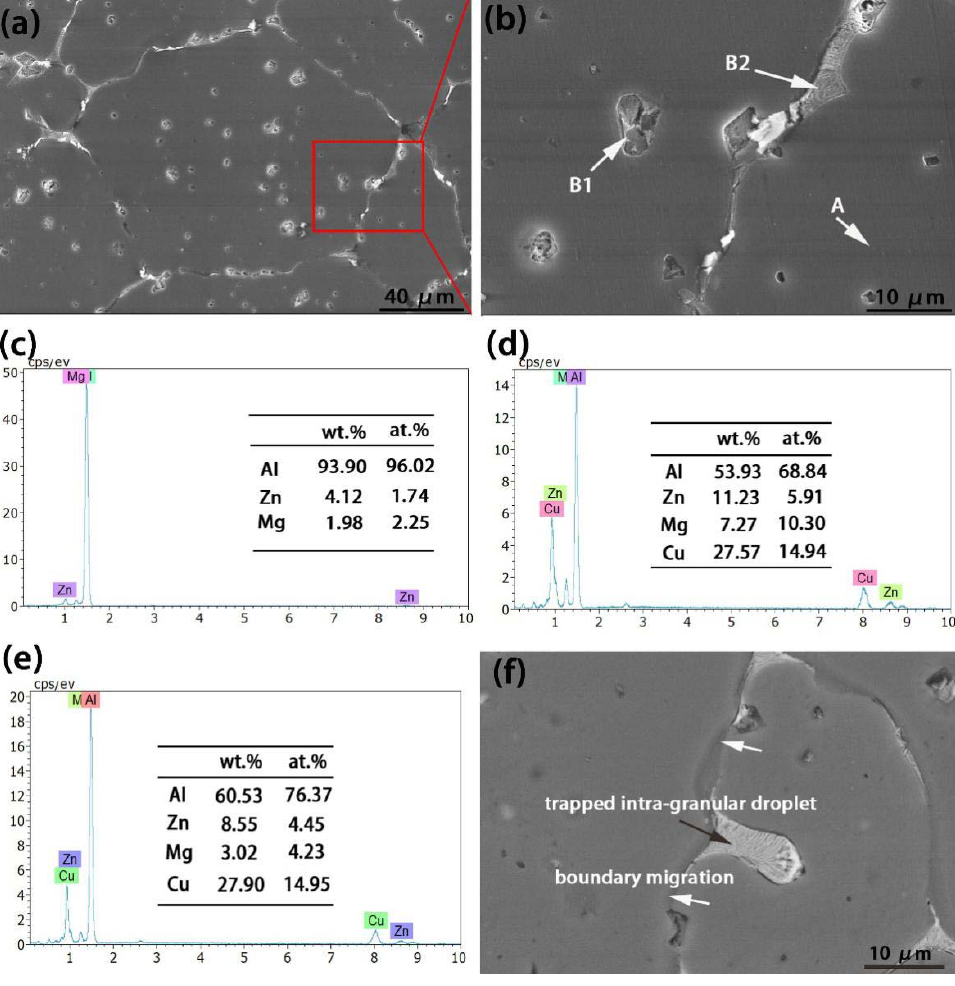
Figure 5. The SEM microstructure and corresponding EDS patterns of RAP-processed samples soaked at 620 °C for 10 min, ( a ) low magnification; ( b ) high magnification; ( c ) EDS patterns of points A in ( b ); ( d ) EDS patterns of points B1 in ( b ); ( e ) EDS patterns of points B2 in ( b ); ( f ) migration of grain boundaries.